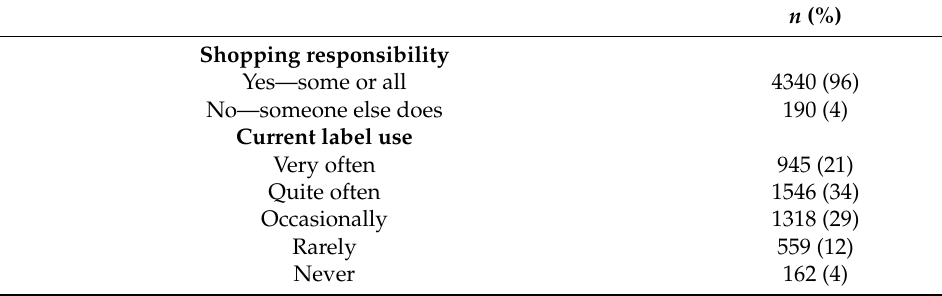
Table 1. Baseline characteristics—food and shopping